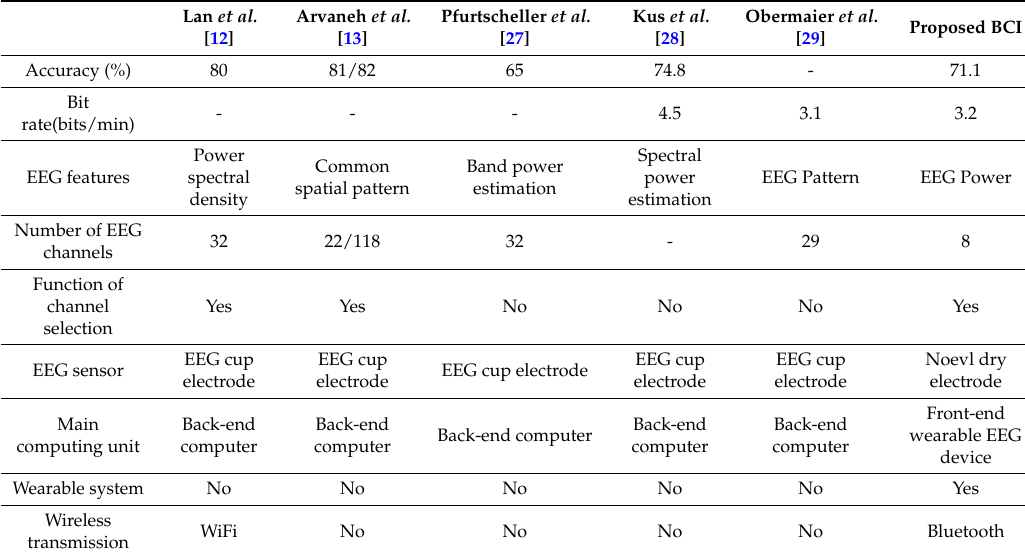
Table 1. Comparison between other BCI systems and the proposed